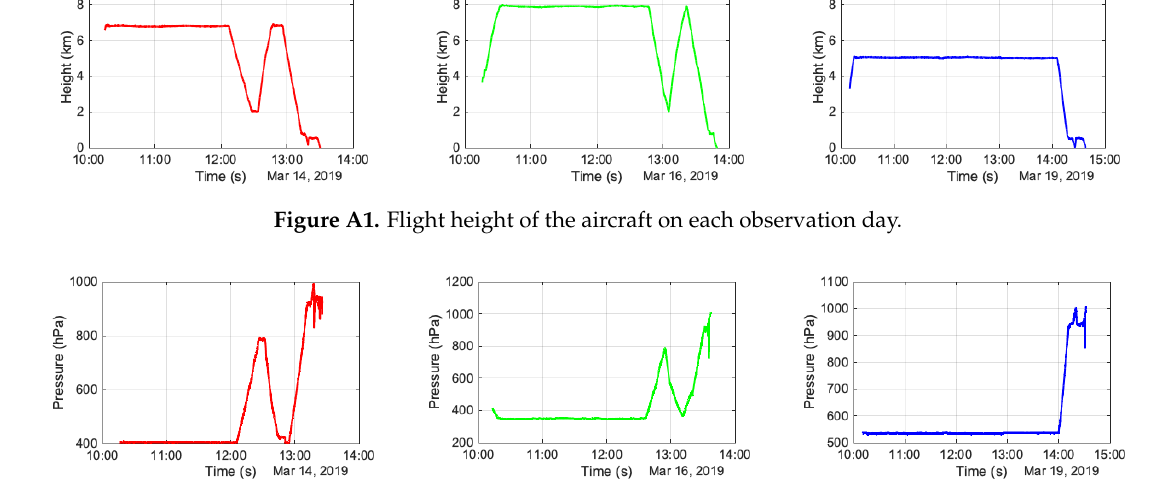
Figure A2. The atmospheric pressure on each observation day during